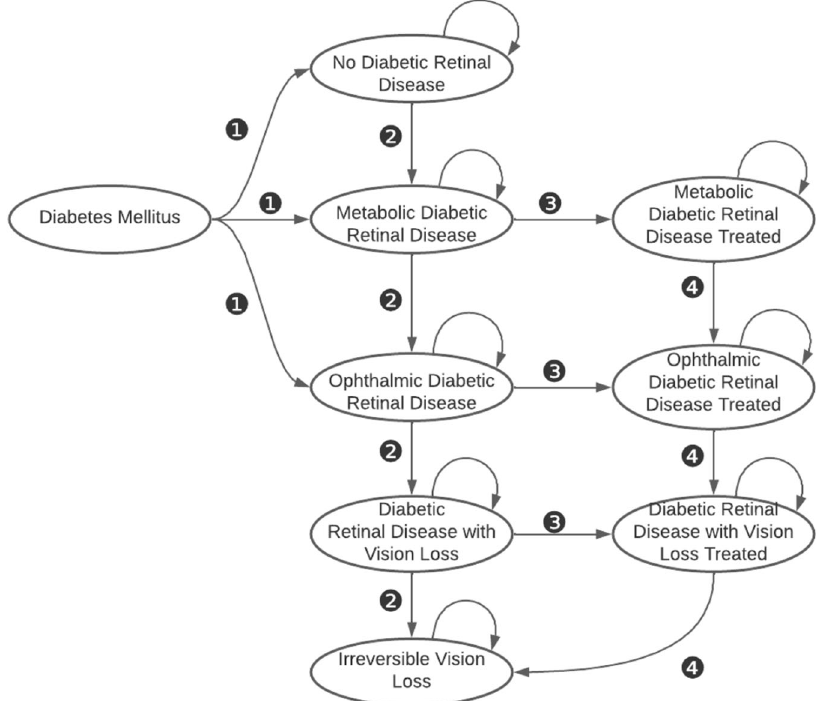
Fig. 3 Markov model showing the states and transitions relevant to diabetic retinal disease used in the current analysis. ❶ Patients with diabetes mellitus presenting to the primary care or endocrine clinic with each of the following states: No Diabetic Retinal Disease, Metabolic Diabetic Retinal Disease, or Ophthalmic Diabetic Retinal Disease. ❷ Natural history transitions of diabetic retinal disease. ❸ Transitions from untreated to treated diabetic retinal disease. ❹ Transitions of treated diabetic retinal disease. The transitions take into account process-of-care metrics i.e., probability of accepting screening and referral in case of a positive screen, probability of disease progression, probability of adhering with recommended treatments. The structure of the Markov model is the same for both screening strategies. Table 1 shows the base-case probabilities and limits of sensitivity analysis for each parameter that are speci fi c to the AI and ECP screening strategies. The details of the transitions speci fi c to each strategy are represented in the decision tree in the supplement (Fig. 3 is preserved and shared on Figshare (https:// fi